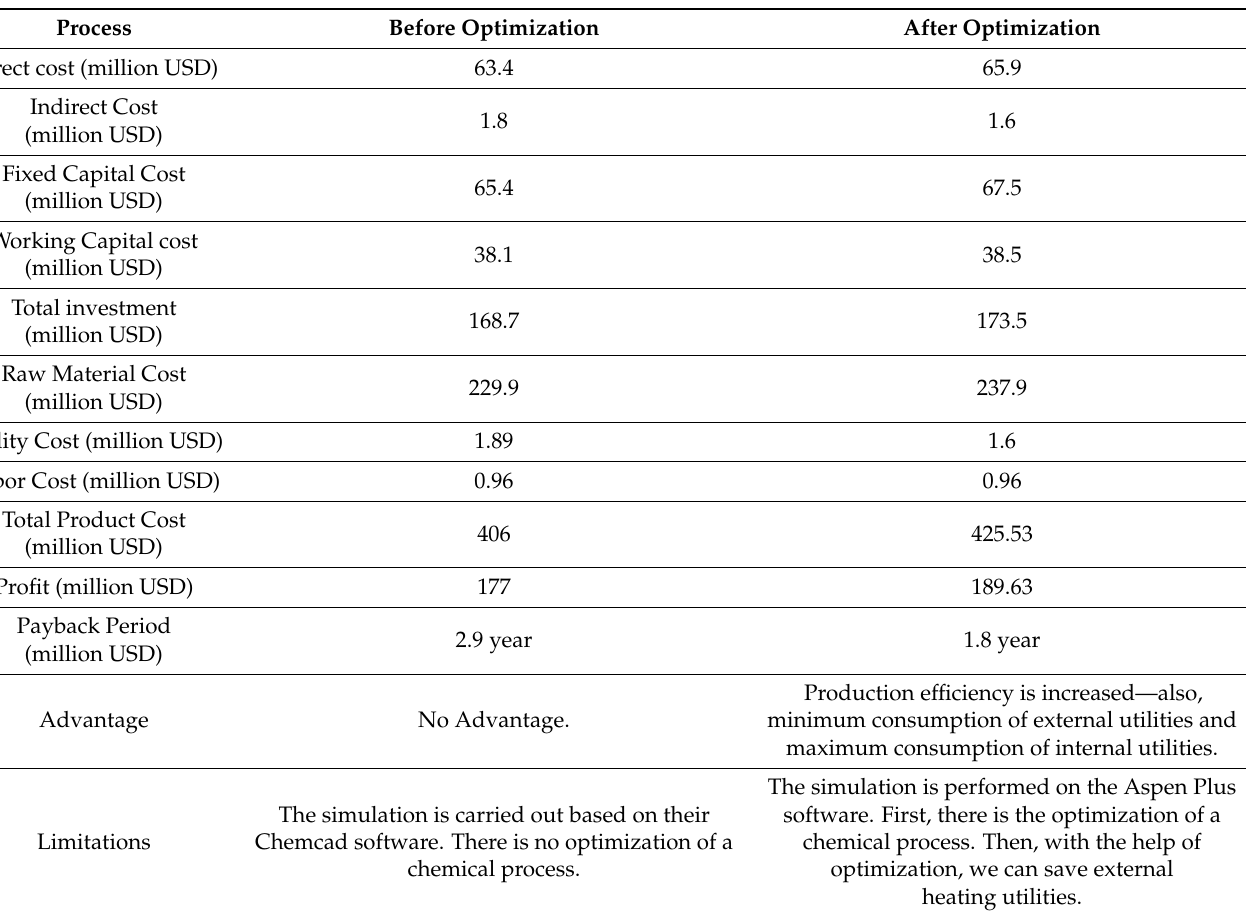
Table 14. Summary of economic parameters, advantages, and disadvantages of processes for H 2 S gas conversion.